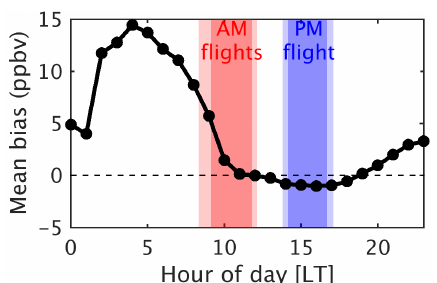
Figure 10. Mean bias in NO 2 surface mixing ratio of CMAQ sim- ulations relative to surface observations averaged at all campaign validation sites. The pale pink (a.m.) and blue (p.m.) shadings indi- cate the time range of GeoTASO flights, while the darker shadings indicate the time range of coincident GeoTASO and surface obser-